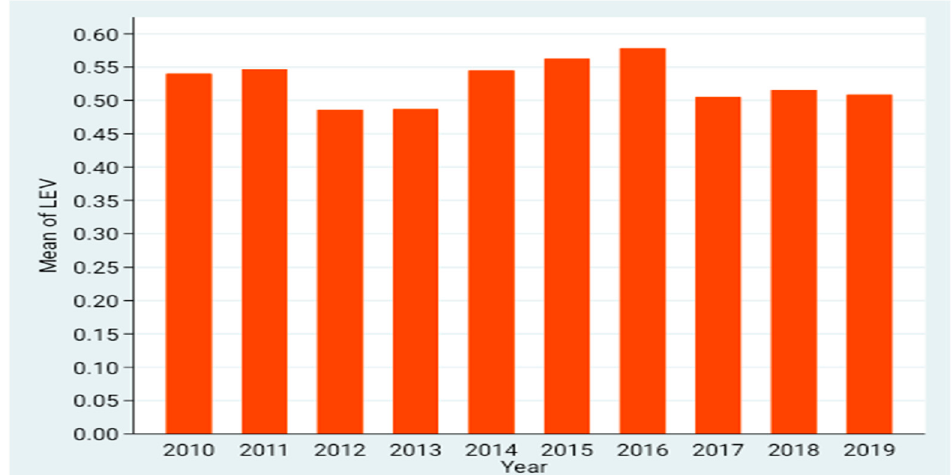
Figure 4. Trends in leverage.